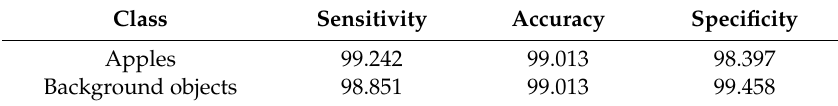
Table 7. Results of performance criteria of segmentation algorithm.